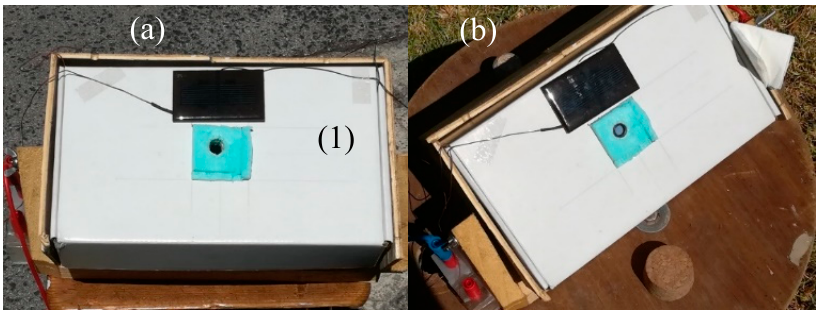
Figure 7. Structure. ( a ) No band-pass (BP) filters; ( b ) with BP filters. ( 1 ) BP filter.